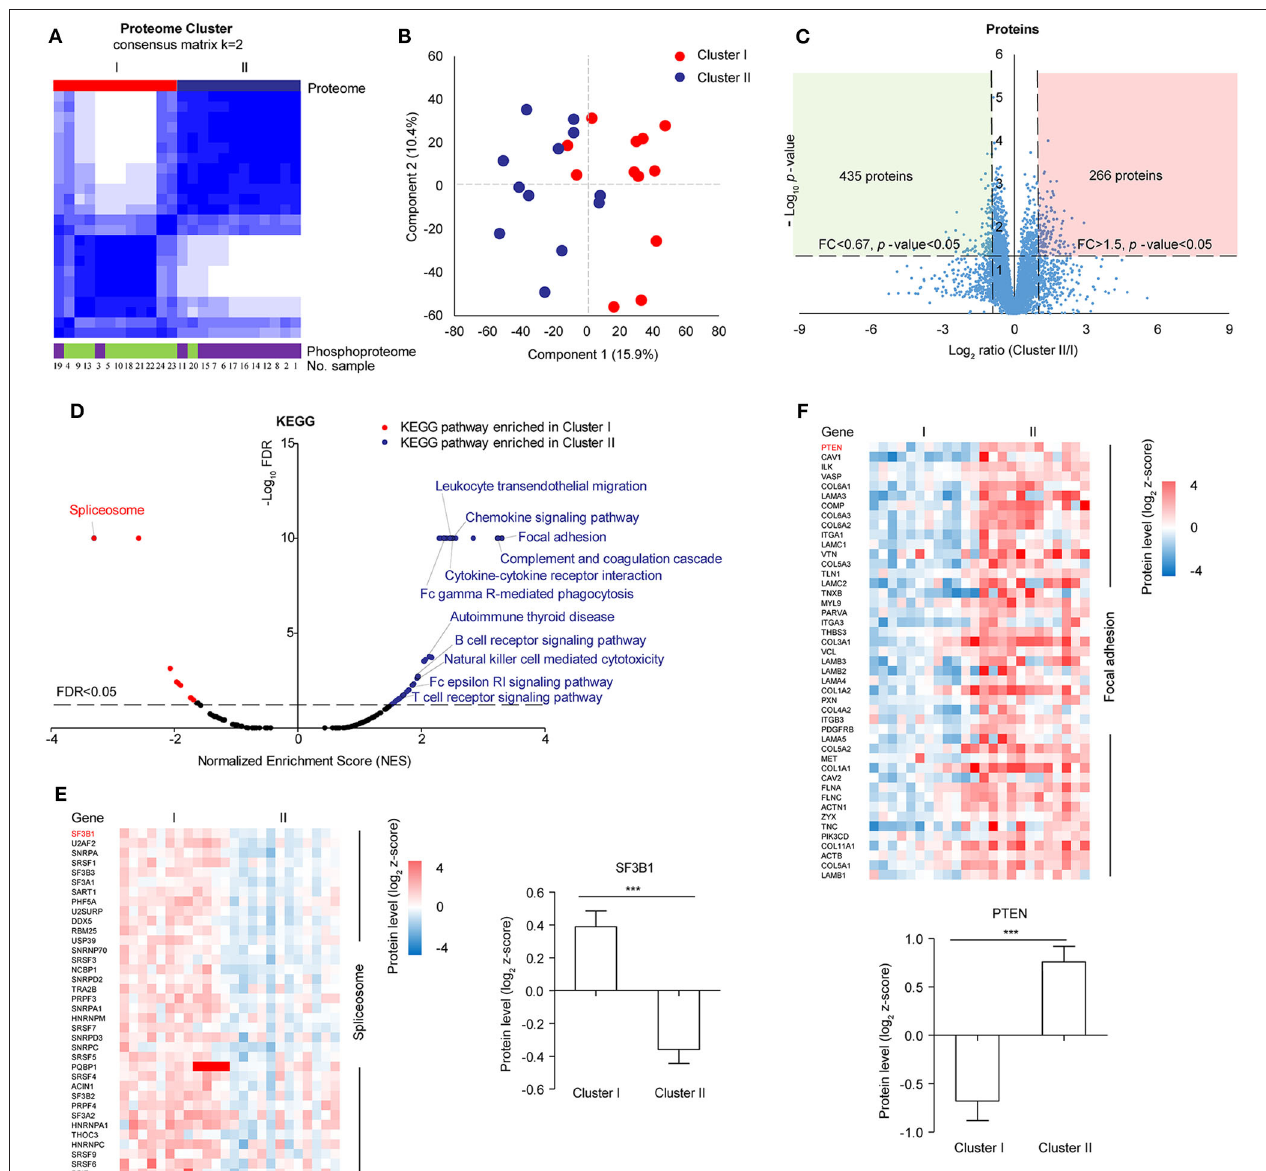
FIGURE 2 | Proteomic clustering of LUSC. (A) Consensus-clustering analysis of proteomic profiling using the top 1,000 most varied proteins with no missing values within twenty-four tumors. Consensus-clustering analysis of phosphomic profiling using the top 1,000 most varied phosphoproteins with missing values < 20% within twenty-four tumors. (B) Principal Component Analysis (PCA) of two proteomic clusters. Red represented Cluster I, and blue represented Cluster II. (C) Scatter plot depicting the fold change of protein abundance comparing cluster II with cluster I. Log 2 fold changes were shown on the x-axis and –log 10 p -values were shown on the y-axis. The vertical dashed lines indicated fold change > 1.5 and the horizontal dashed line indicated p -value < 0.05 ( t -test). (D) GSEA analysis of proteomic data between cluster I and cluster II. The scatter plot showed the enriched KEGG pathways from the Molecular Signatures Database (MSigDB). Normalized enrichment score (NES) was shown on the x-axis and -log 10 FDR was shown on the y-axis. The horizontal dashed line indicated FDR < 0.05. The labeled pathways were the most significant pathways or pathways consistent with previous data reported in samples from Western countries. (E) Differential protein expression of cluster I and cluster II in spliceosome. (F) Differential protein expression of cluster I and cluster II in focal